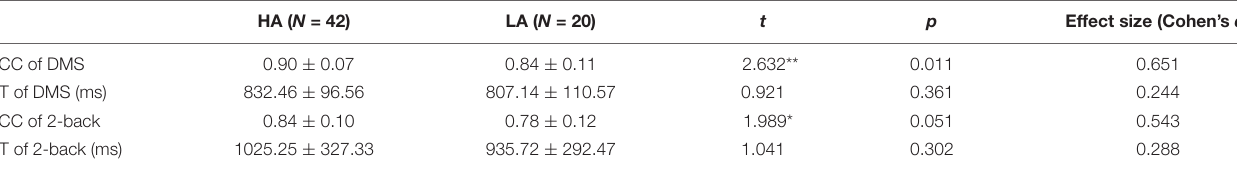
TABLE 2 | Working memory performance measurements (mean ± standard deviation).